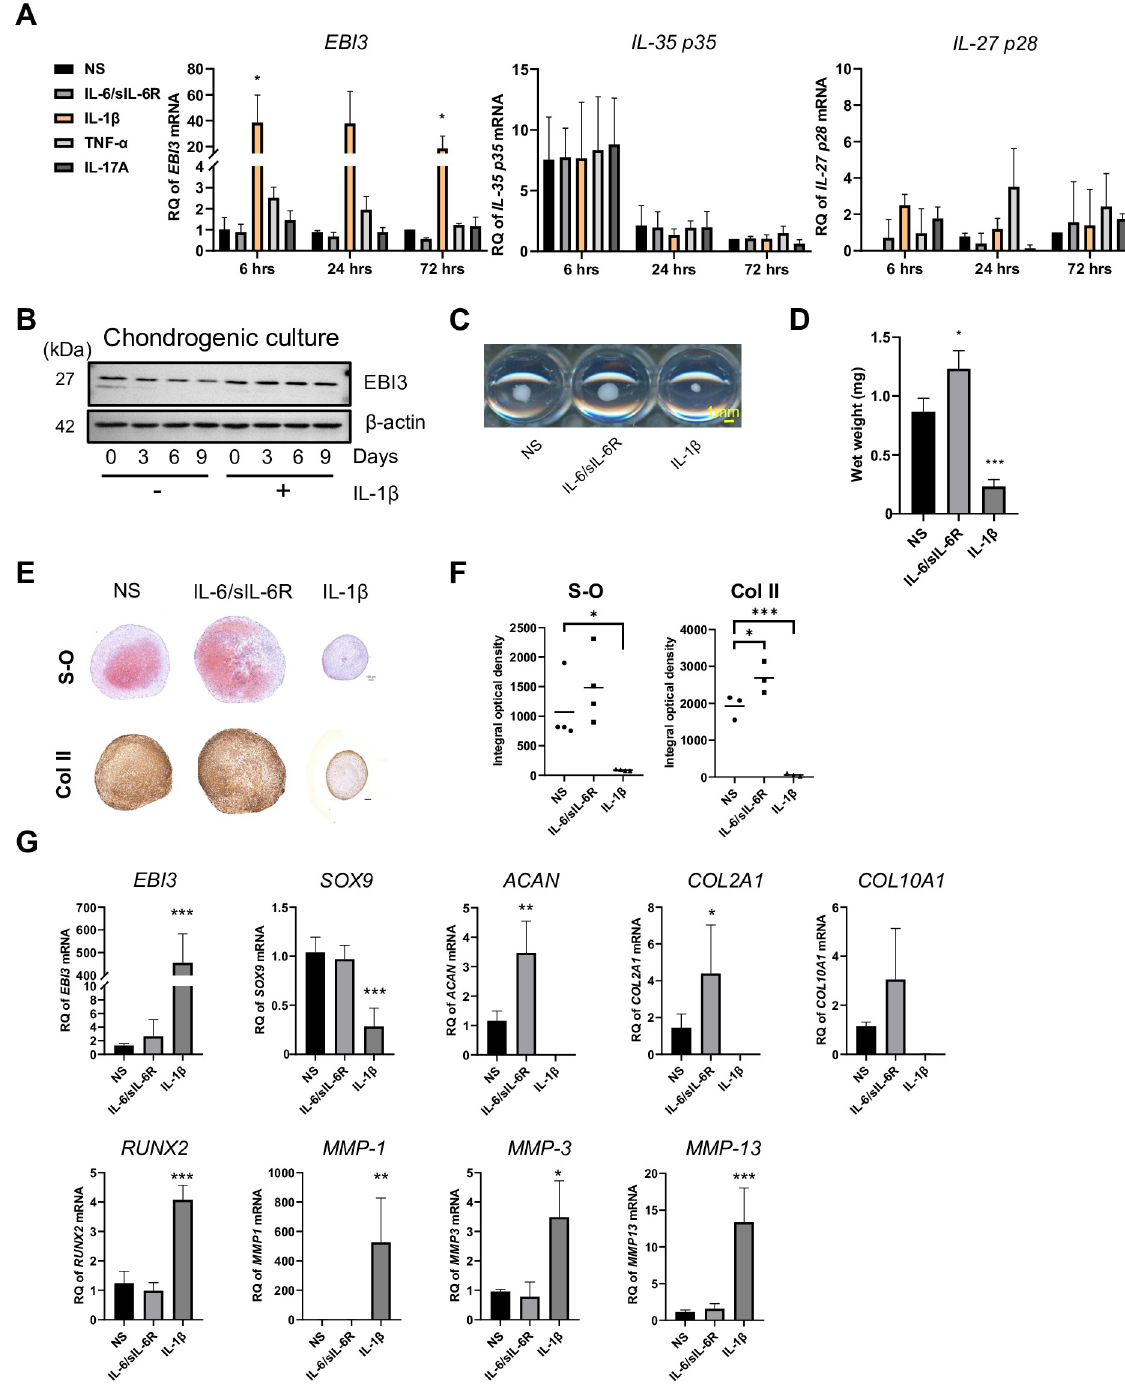
Fig 4. IL-1 β up-regulates EBI3 and inhibits chondrogenic differentiation of MSCs. (A-G) MSCs were cultured as cell pellets in chondrogenic medium. (A) The mRNA levels of the indicated genes were determined by RT-qPCR at the indicated time points. (B) EBI3 protein levels in chondrogenic MSCs treated with or without IL-1 β were determined at the indicated time points by Western blotting. β -actin was used as a loading control. Results are representative of 3 independent experiments with similar findings. (C-G) MSCs were cultured with no stimulation (NS), IL-6/sIL-6R or IL-1 β for 21 days. (C) Photographs of the pellets. Scale bar, 1mm. (D) Wet weight of the pellets. (E) Pellets were stained with Safranin O (S-O) or anti-type II collagen (Col II) antibody. Scale bar, 100 μ m. Results are representative of 4 independent experiments with similar findings. (F) Densitometric analysis of (E) was performed to show integral optical density (IOD). (G) The mRNA levels of the indicated genes in cell pellets were determined by RT-qPCR on day 21. (A, D, F, G) Quantified data are expressed as